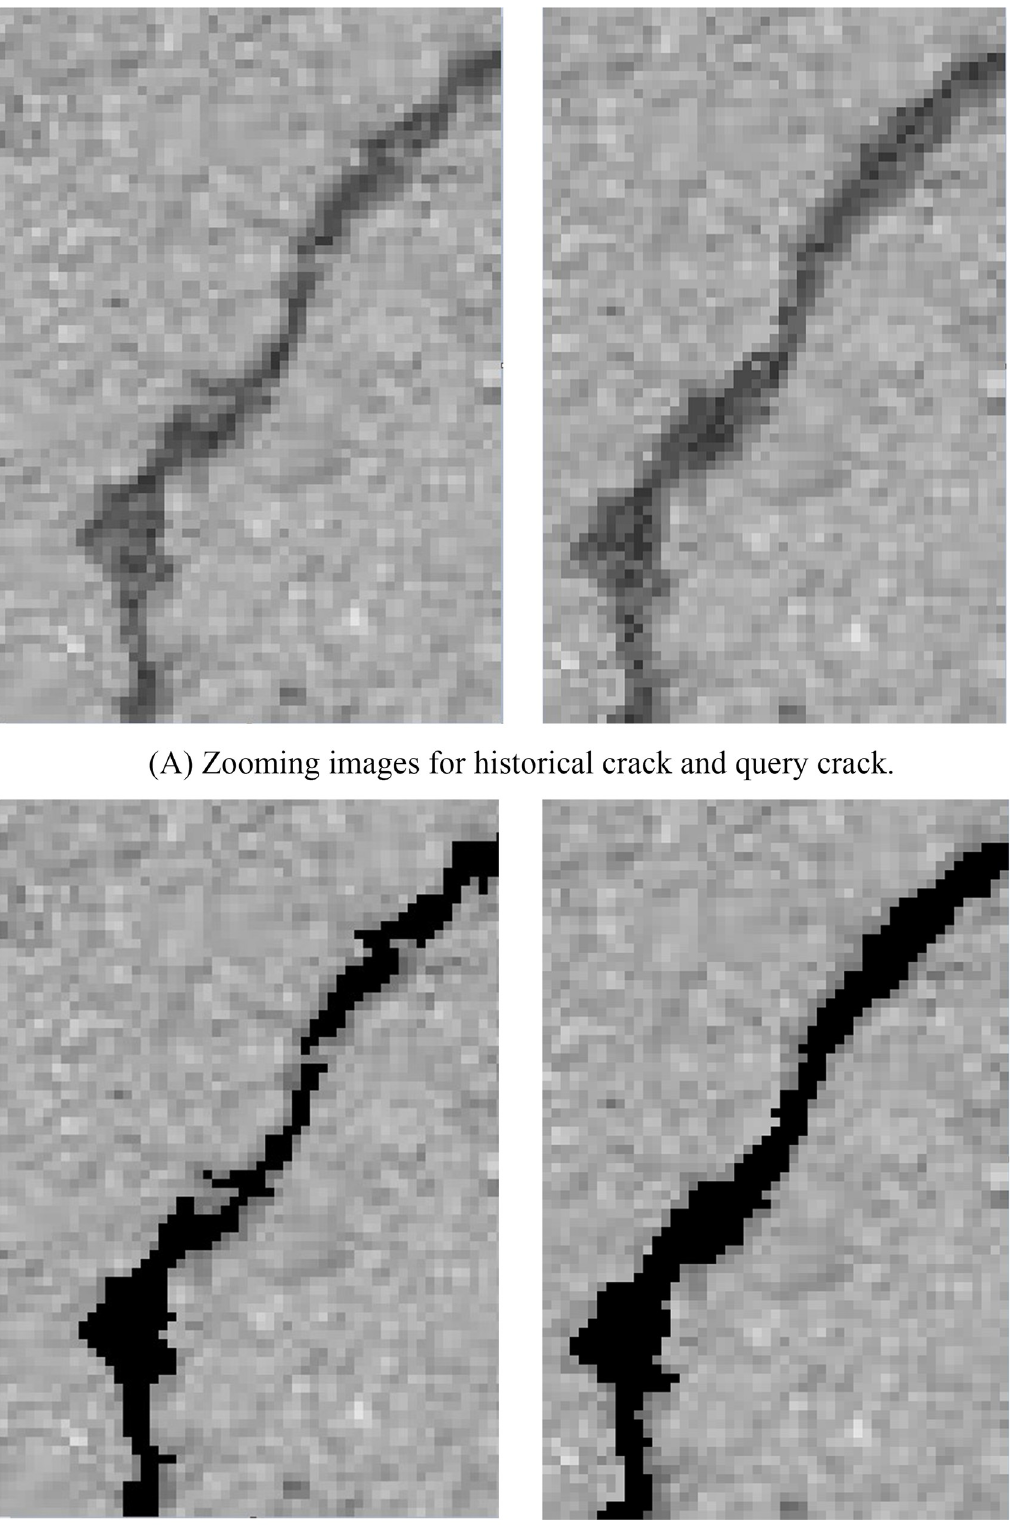
Fig 13. Crack growth on Linjiang Road